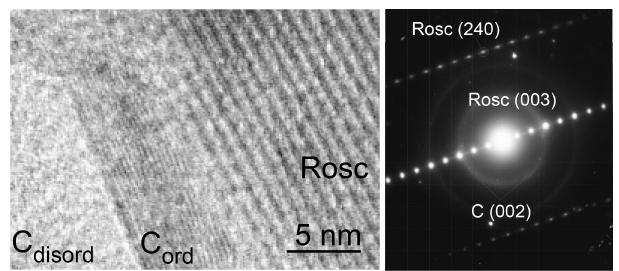
Figure 5. Fragment of an partially ordered carbon film at the surface of roscoelite and its corresponding SAED pattern (ICDD – 00-010- 0496) in Sh1 samples.